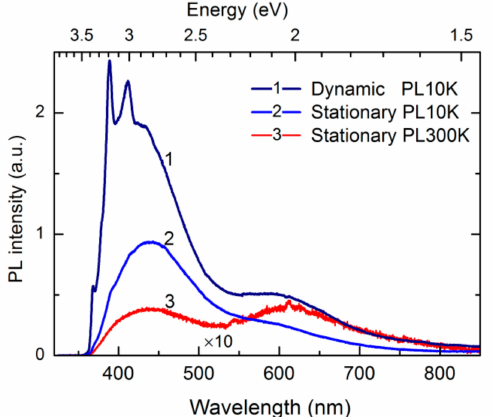
Figure 4. Photoluminescence (PL) spectra of nanostructured a-Si:Al illustrating representative features of emission addressed in this study: Instability under UV irradiation, temperature dependence, and surface e ff ects. Here, spectra labeled Dynamic and Stationary represent two PL acquisition modes: With continuously translated specimen (movable probe position) and conventional probing at a fixed position. Note that the room temperature PL spectrum is magnified by ×